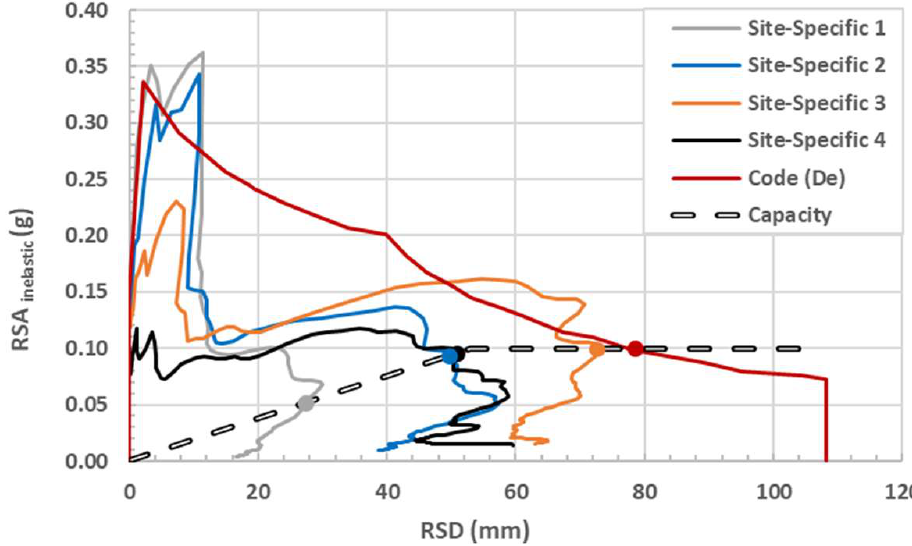
Figure 11. Superposition of the capacity curve and the ADRS demand curves (code spectrum and 4 average site-specific spectra).